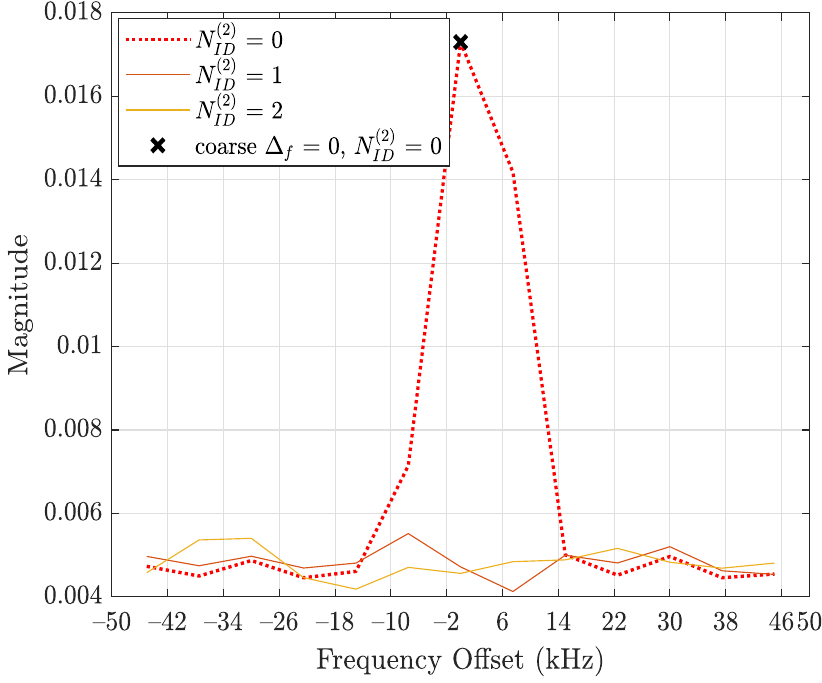
Figure 8. Primary synchronization signal correlations versus frequency offset.